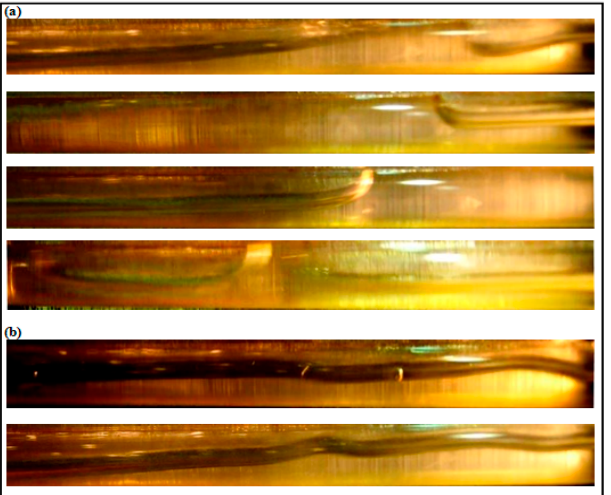
Figure 13. ( a ) Slug flow regime without DRP (V sl = 0.72 m/s, V sg = 0.41 m/s); ( b ) Transition from Slug to Stratified Wavy flow regime using 100 ppm DRP.